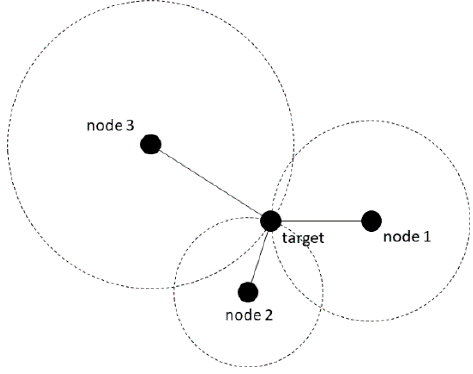
Figure 2. Received Signal Strength (RSS)-based localization with three observer nodes.